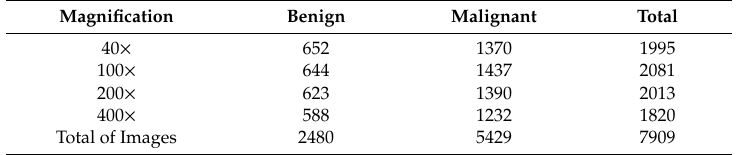
Table 1. BreakHis dataset image distribution in terms of class and magnification factor.